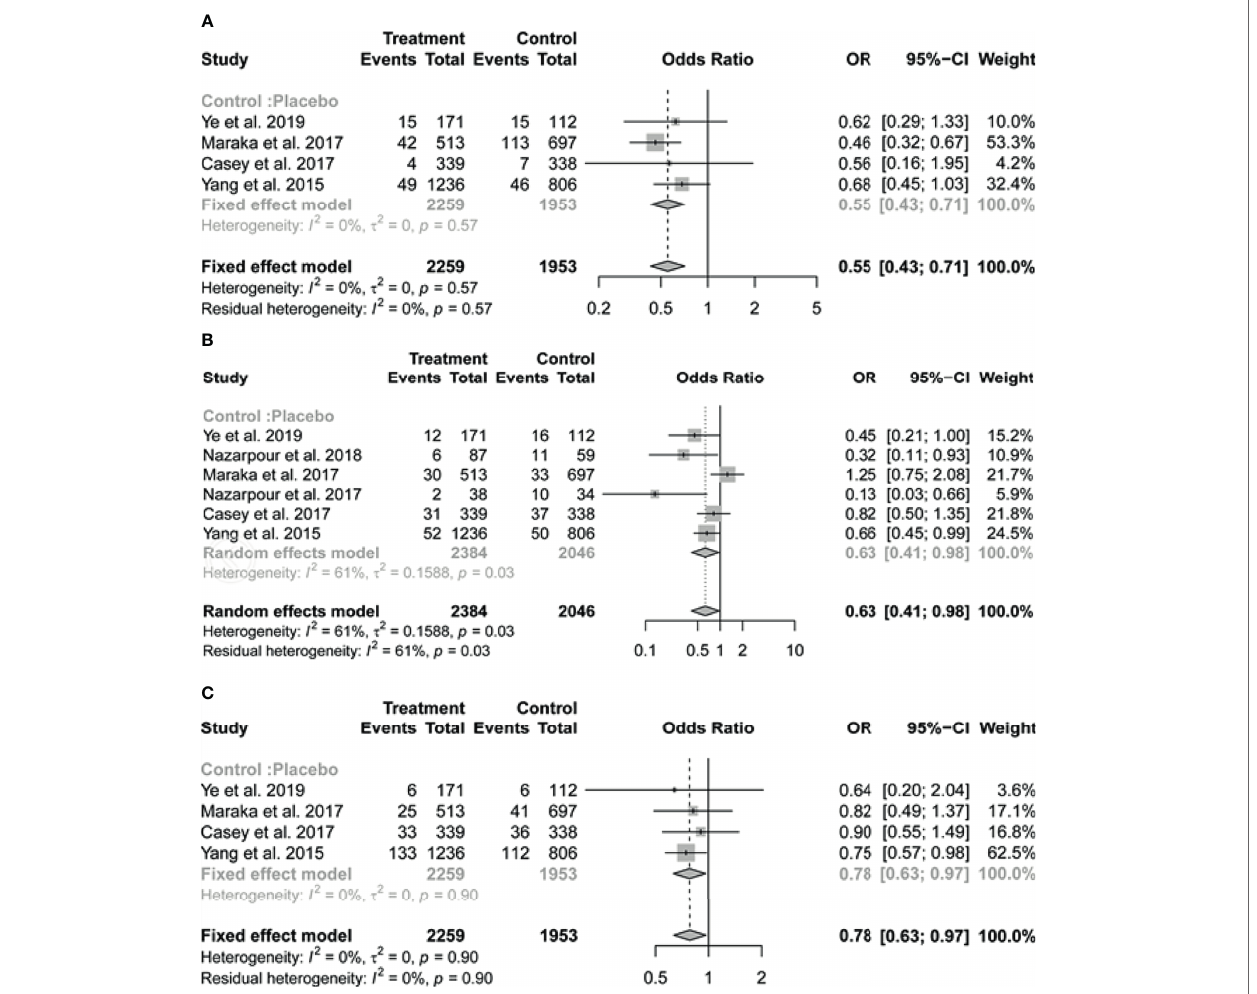
FIGURE 2 | Forest plots of odds ratio (OR) and 95% con fi dence interval (CI) of pooled studies comparing levothyroxine treatment group to control group for the risk of (A) pregnancy loss, (B) preterm birth and (C) gestational